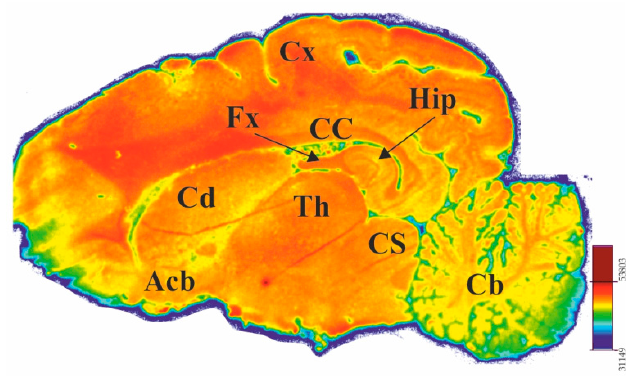
Figure 4. Representative sagittal porcine brain slice showing distribution of the binding sites of [ 18 F] ICF24027 in vitro (total binding at 5.26 nM). Abbreviations: Acb = Nucleus accumbens, Cb = Cerebellum, CC = Corpus callosum, Cd = Nucleus caudatus, Cx = Cortex, CS = Colliculus superior stratum, Fx = Fornix, Hip = Hippocampus, Th = Thalamus.